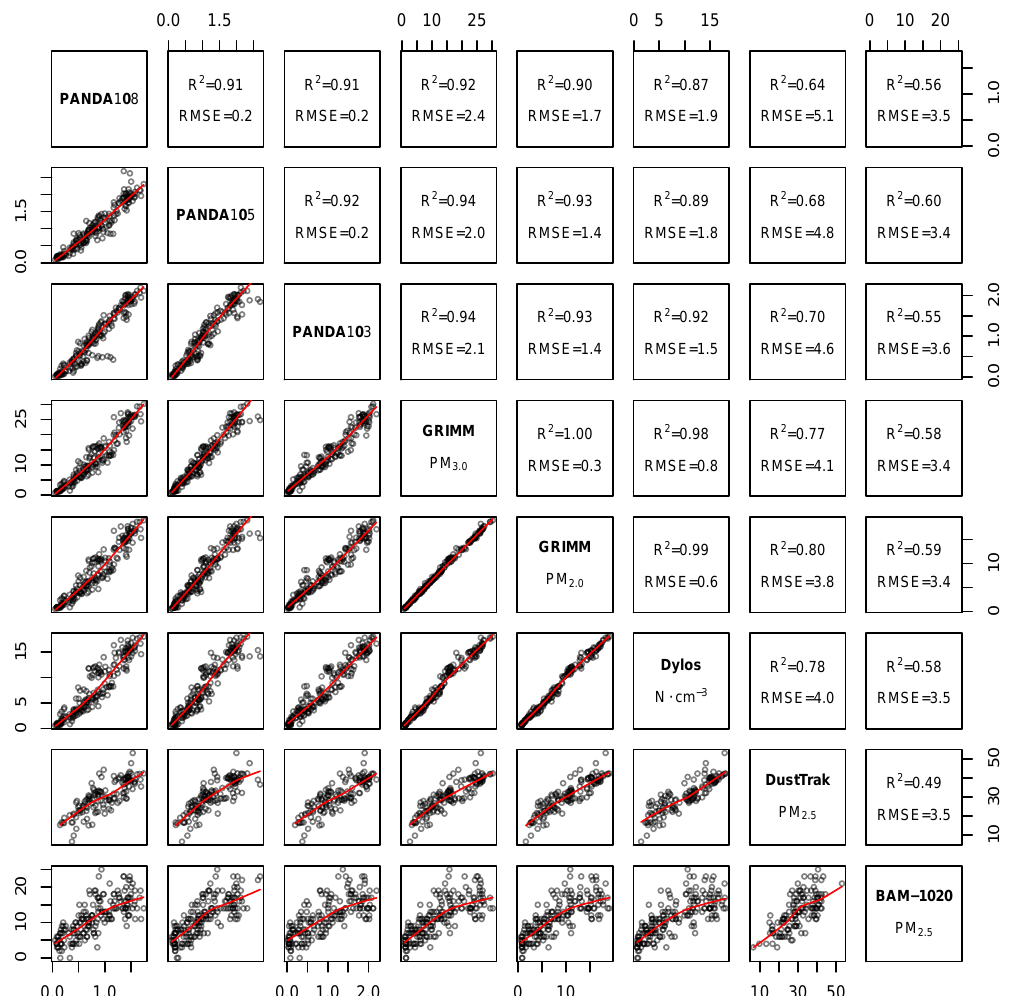
Fig. 2. Intercomparisons between hourly data from all instruments deployed at the West Oakland site from 15 April 2013 to 23 April 2013. Upper-right set of panels: R 2 and RMSE for linear models fit using ordinary least squares (OLS). Lower-left set of panels: loess smoothers superimposed on pairwise plots of the hourly data.